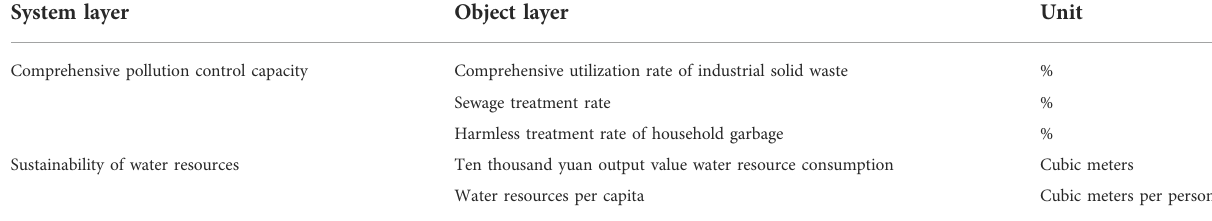
TABLE 1 Eco-environmental protection index